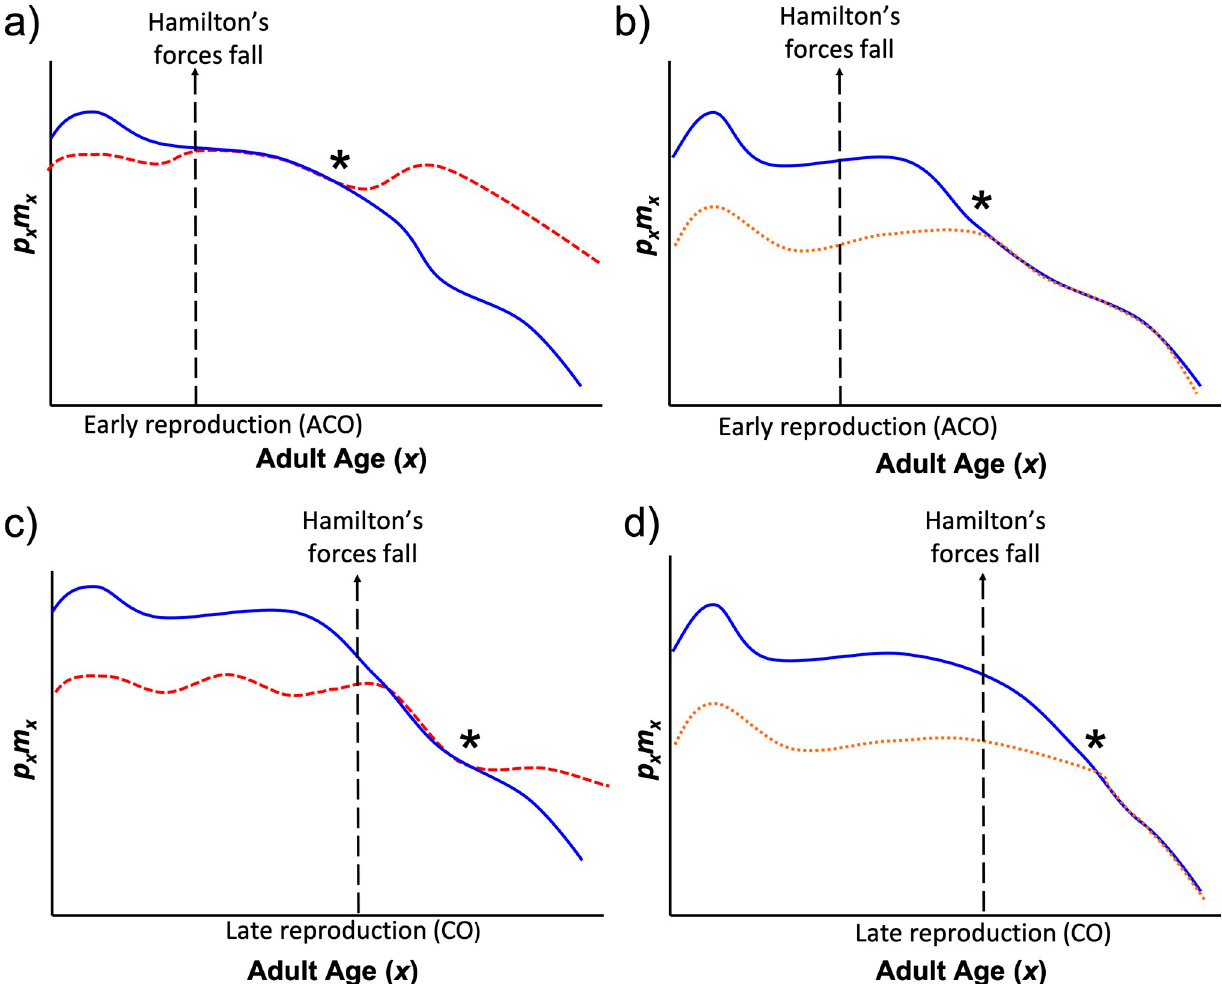
Fig 1. Hypothetical p x m x curves of flies from two different demographics exposed to various diets. p x m x is age-specific survival probability ( p x ) ). Dashed red trend lines represent p on a long-abandoned diet, solid blue on an evolutionarily recent multiplied by age-specific female fecundity ( m x x m x diet, and dotted orange on an entirely novel diet. (a) Flies evolving under an early reproduction regime should fare as well or better on their evolutionarily recent diet as on a past ancestral diet at early ages. But at later ages, we predict that individuals should fare better on a long-abandoned diet when the forces of natural selection have weakened enough to prevent sufficient adaptation to the food imposed in recent evolutionary time. (b) Flies should perform significantly better on an evolutionarily recent diet as opposed to an entirely novel diet, particularly at early adult ages. (c) If reproduction is pushed to later ages, we would expect a longer period of sustained function on the evolutionarily recent diet and a switch to superior function with the long-abandoned diet to occur at later ages or not at all as indicated by the asterisk. (d) Our theory also implies a longer period of sustained function on the recent diet compared to an entirely novel diet. Convergence in these trends would be expected at even later ages as indicated by the asterisk. This last prediction was not tested in our experiments.